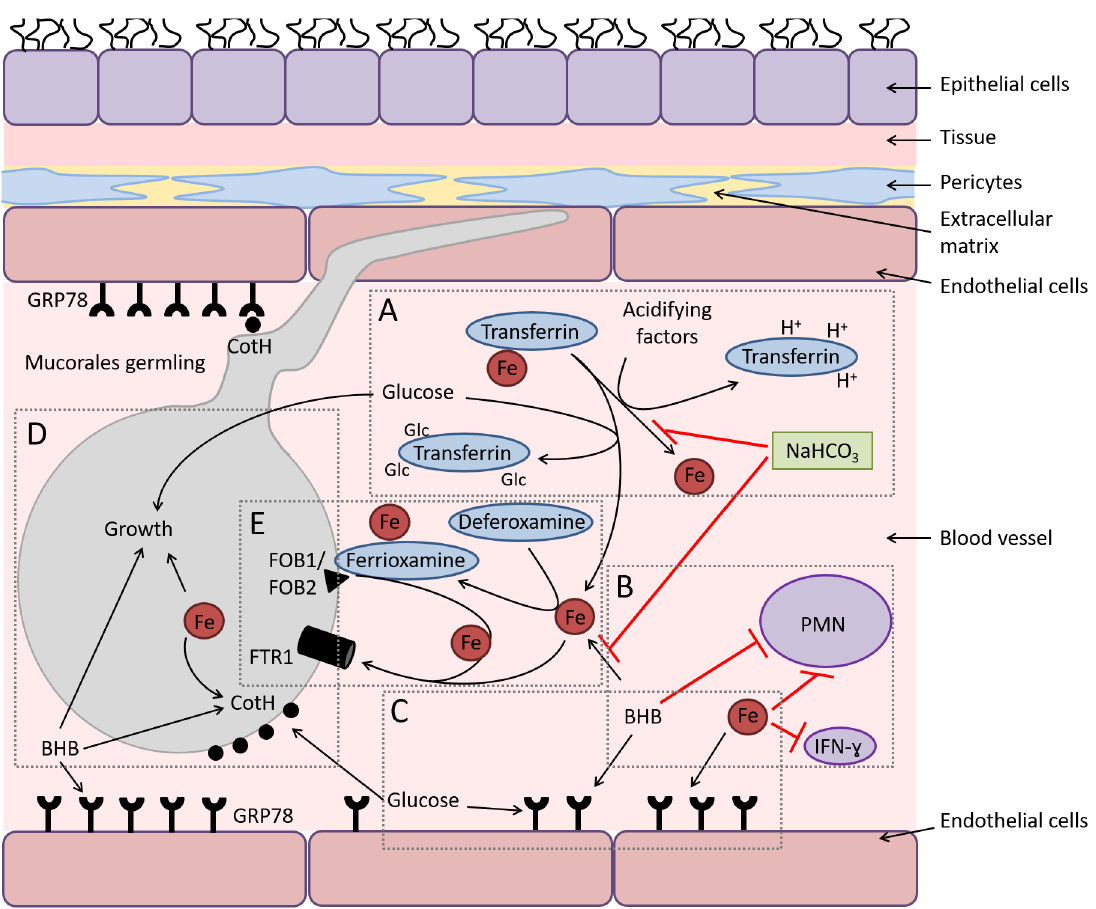
Fig 1. Diagram depicting the interactions of Mucorales with endothelial cells during hematogenous dissemination/ organ seeding and the effect of host factors on these interactions and on the immune response. (A) Hyperglycemia and ketoacidosis result in liberationof iron from serum-sequesteringproteins (e.g., transferrin) via glycosylation and protonation, respectively. (B) Ketonebodies (e.g., β -hydroxy butyrate [BHB]) and free iron negatively affect the immune responseto the infection, whilesodium bicarbonate (NaHCO 3 ) reverses this negativeeffect by preventingiron release from transferrin and neutralizing acidity. (C) Surface expressionof glucose-regulatorprotein 78 (GRP78) on endothelialcells is enhanced to cope with the stress elicitedby hyperglycemia, free iron, and ketone bodies.(D) Glucose, free iron (transportedby the high affinity iron permease [Ftr1p]), and BHB also enhancethe expressionof fungalcell surface CotH, which results in invasionof the endothelium and augmentation of fungalgrowth. (E) In deferoxamine-treatedhosts, the iron-richferrioxamine binds to its fungal receptor(ferrioxaminebindingproteins[Fob1/Fob2]) then releases iron via a reductivestep prior to feedinginvadingMucorales via Ftr1p